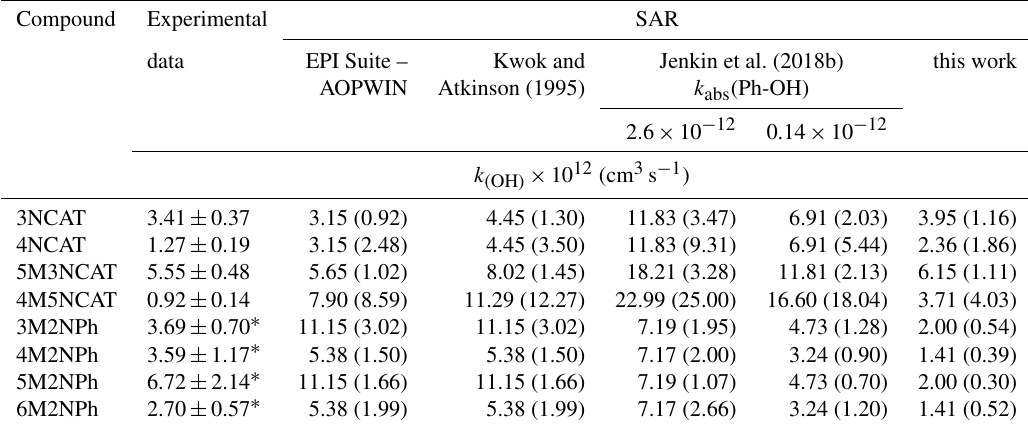
Table 4. Experimental and SAR-estimated rate coefficients of monoaromatic hydroxylated nitro compounds with the radicals. In brackets are the ratios of the estimated values versus experimental data ( k calc /k exp ). Compound Experimental SAR EPI Suite – Kwok